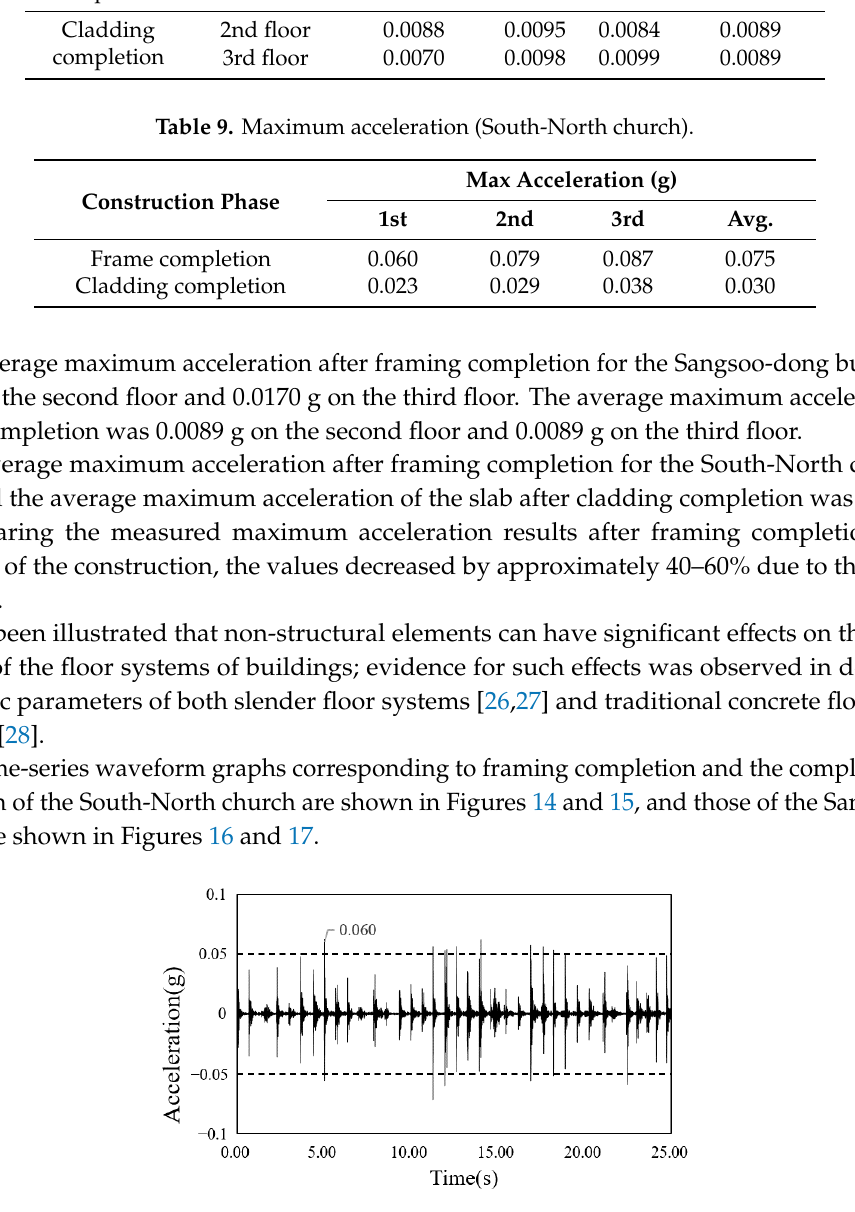
Figure 15. Time history of acceleration after cladding completion (South-North church). Figure 16. Time history of acceleration after framing completion (Sangsoo-dong building).